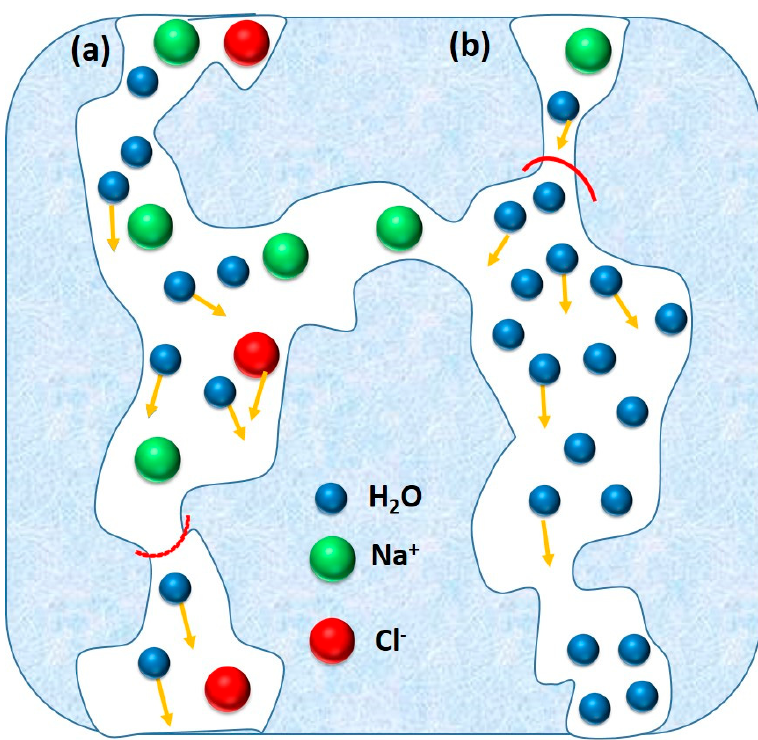
Figure 24. Illustration of percolative porous pathway and diffusion of water and hydrated salt ions through ( a ) mesoporous region that non-selective to small amount of hydrated salt ions, and ( b ) microporous constrictions that only allows the passage of water molecules.